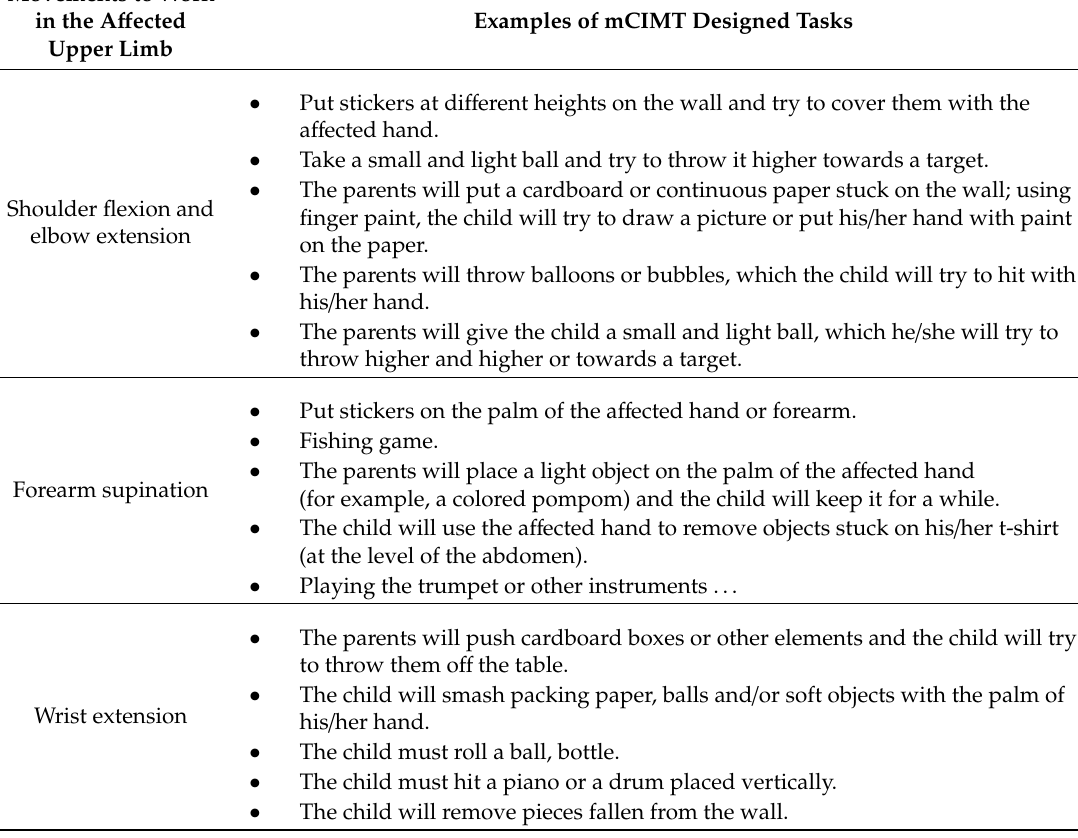
Table 1. Example of “modified Constraint-Induced Movement Therapy” (mCIMT) designed tasks. Movements to